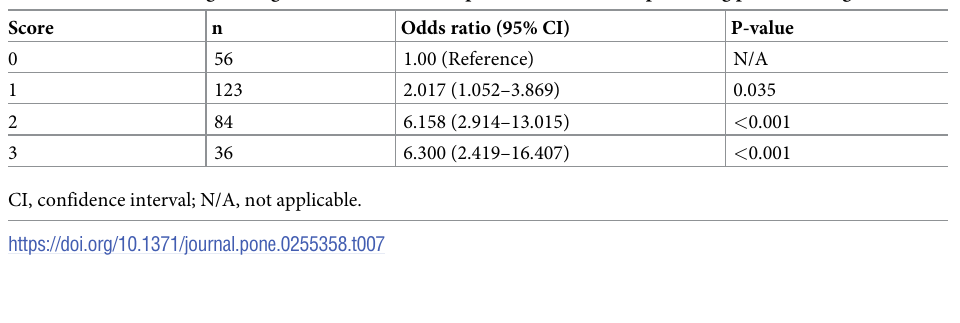
Table 7. Multivariate logistic regression of a combined plasma-leak score for predicting plasma